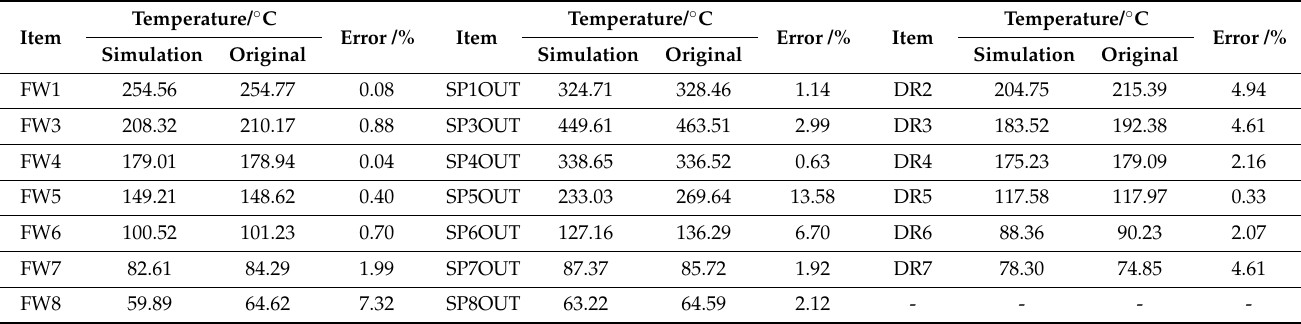
Table A6. Verification of simulation results of thermal power units.